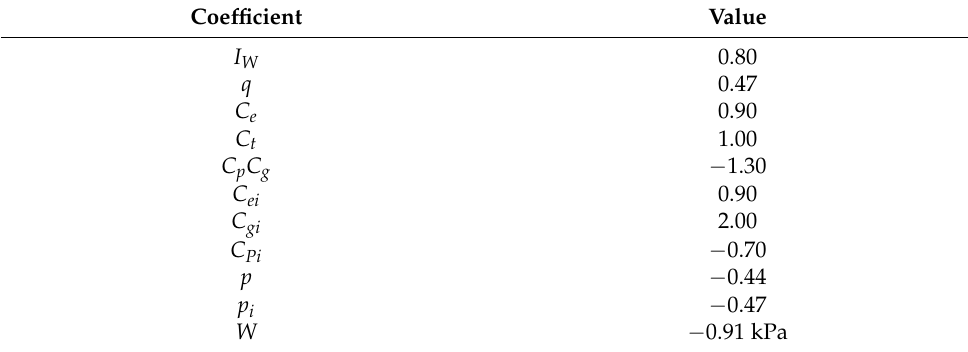
Table A2. Design Wind Load as per NBCC 4.1.7.3.